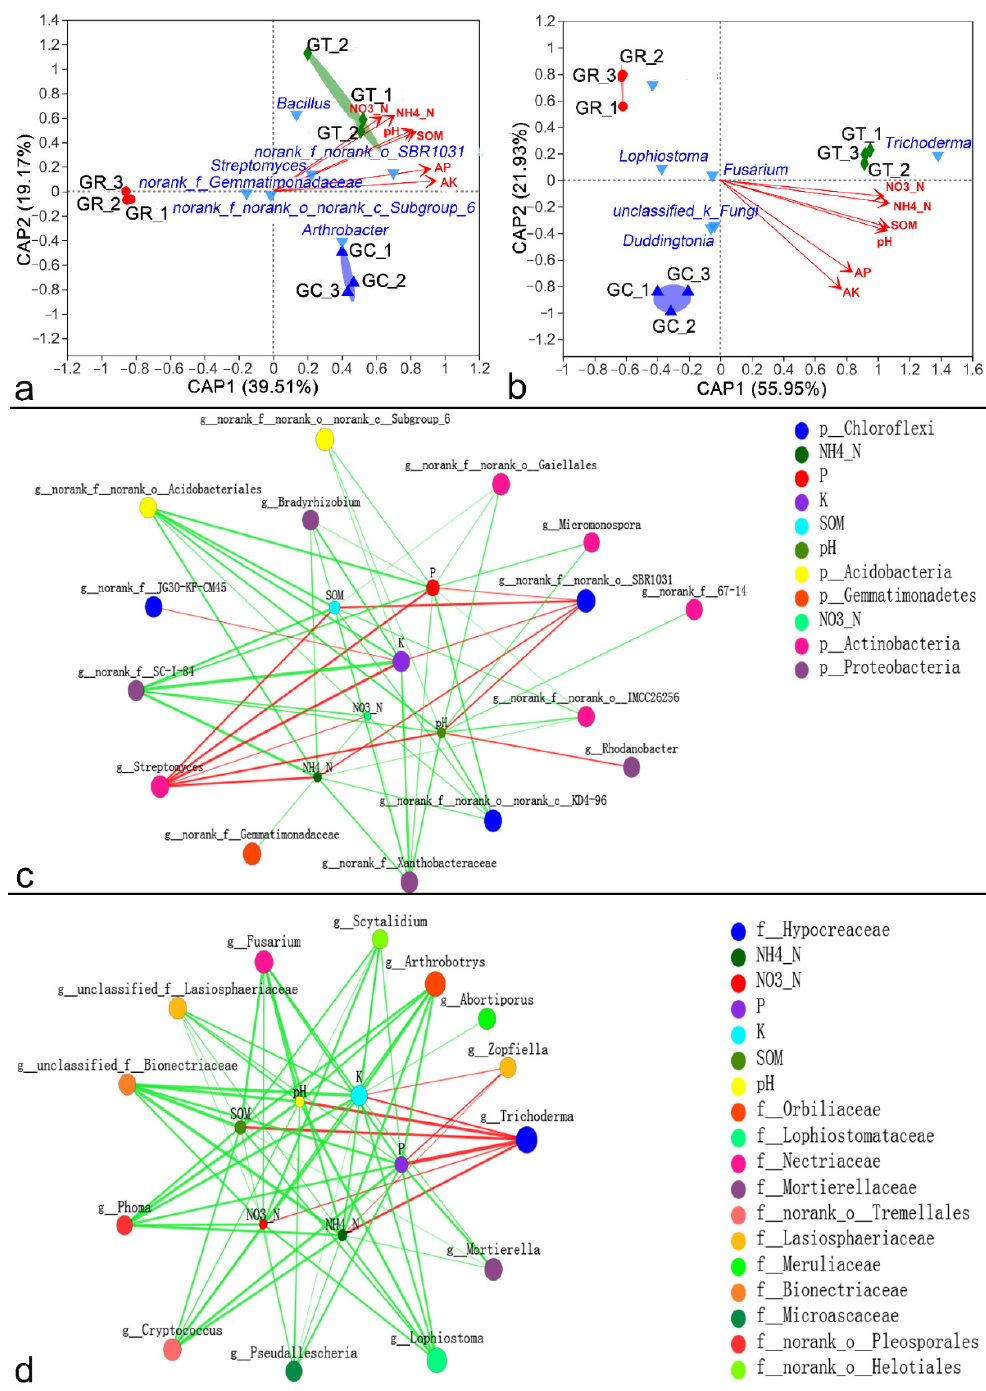
Figure 5. Distance-based redundancy analysis (db-RDA) plot showing the relationships of environ- mental factors and treatments with bacterial ( a ) and fungal ( b ) community structure. The values on axes 1 and 2 are the percentages explained by each axis. Circles, upright triangles, and diamonds represent the GR, GC, and GT samples. The inverted triangles represent the top six microbial species in terms of abundance, and the red arrows represent environmental factors. Two-way correlation network analysis between environmental factors and the top twenty bacterial ( c ) and fungal ( d ) gen- era. The size of the node is proportional to the genus abundance and environmental factors. Node color corresponds to the family taxonomic classification. Edge colors represent positive (green) and negative (red) correlations, and the edge thickness is equivalent to the correlation